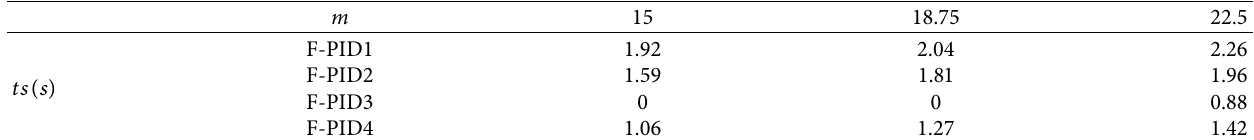
Table 7: Regulation time changes with the quality of the underwater